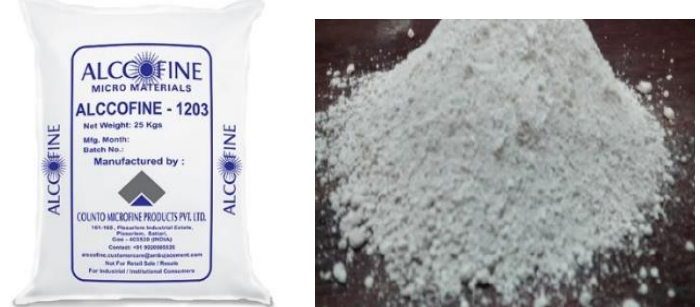
Figure 1. Alccofine